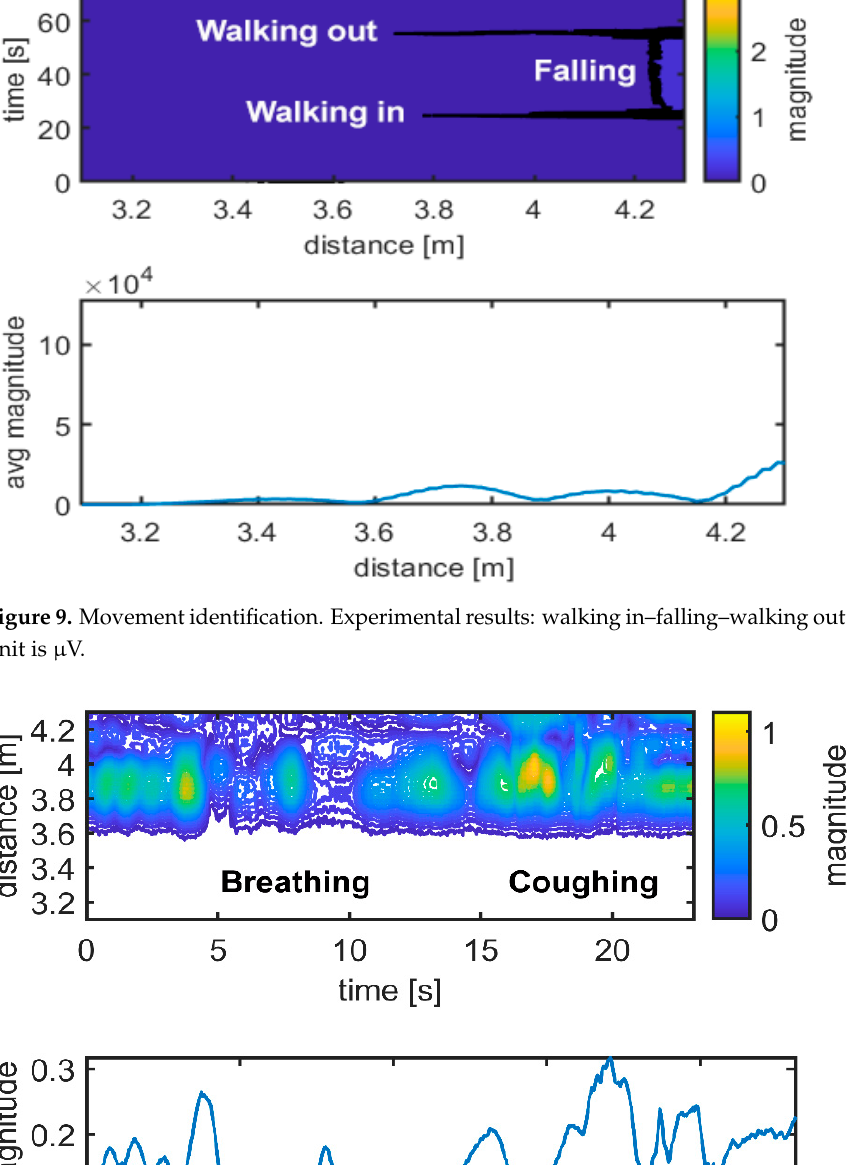
Figure 9. Movement identification. Experimental results: walking in–falling–walking out. Magni- tude unit is µV.